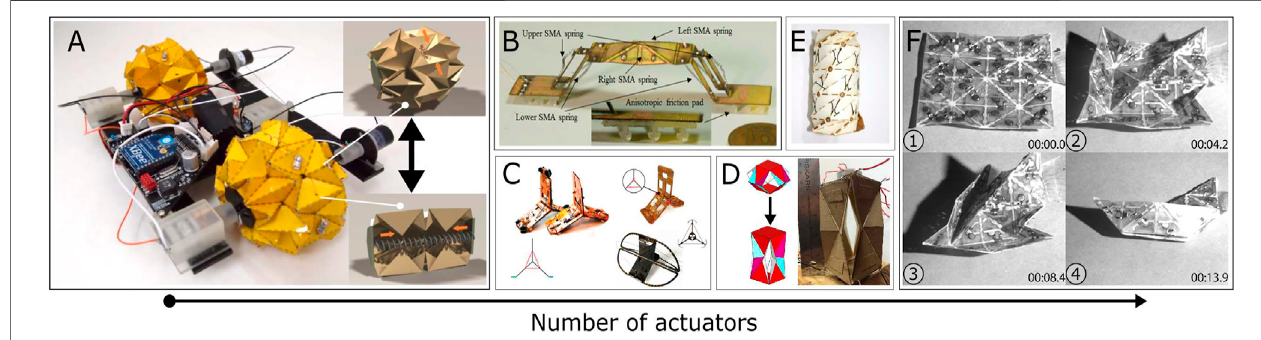
FIGURE 1 | Diversity of SMA-Based origami robots. Origami robots arranged by the number of actuators: (A) A deformable wheel robot (Lee et al., 2013). (B) An inchworm-inspired crawling robot (Koh and Cho, 2013). (C) Different versions of a bi-modal locomotion origami robot of Paik ’ s group (Zhakypov et al., 2015; Zhakypov et al.,2017; Zhakypovand Paik, 2018). (D) Aself-deployableliftingstructure (Woodet al.,2016). (E) A “ shapeswitching ” modulewithcontrollable stiffness(KimJ.et al., 2015). (F) A “ 2D → 3D ” shape-morphing system (Hawkes et al., 2010).